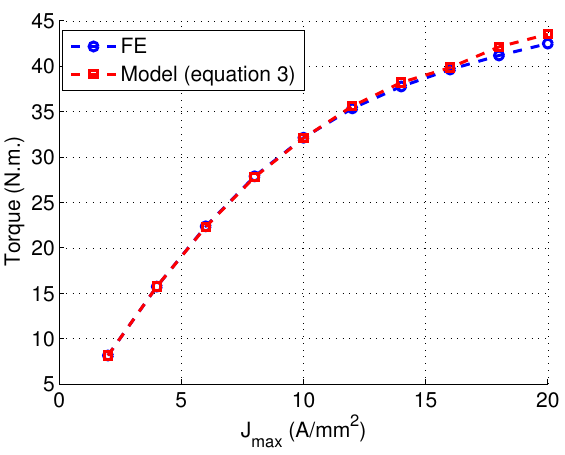
Figure 5. Comparison between Equation (4) and FE